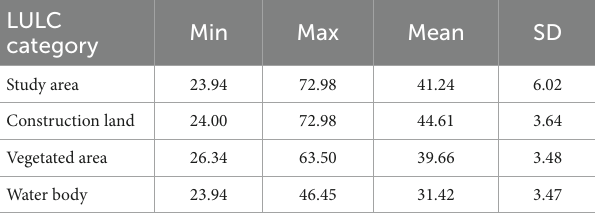
TABLE 2 Temperature statistics in different LULC categories ( ° C).